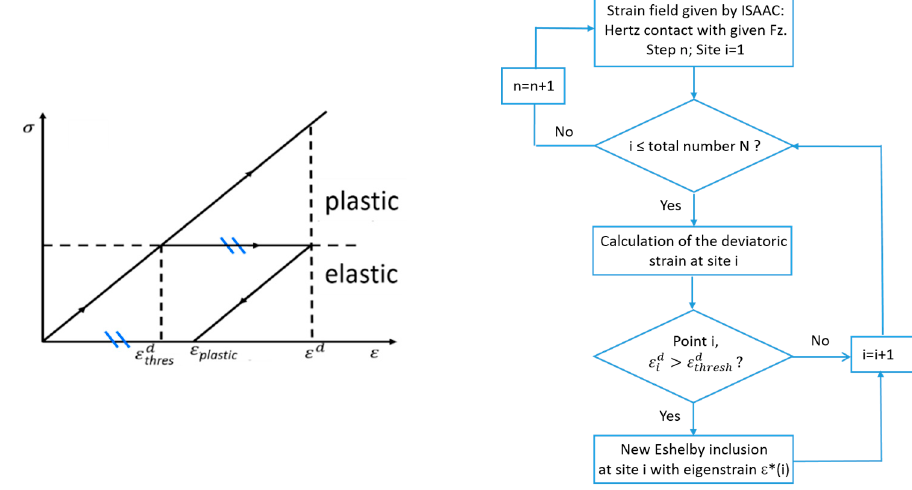
Figure 1. ( left ) Schematic description of residual plastic strain in a linear elastic–perfectly plastic model. ( right ) Schematic diagram of the mesoscopic